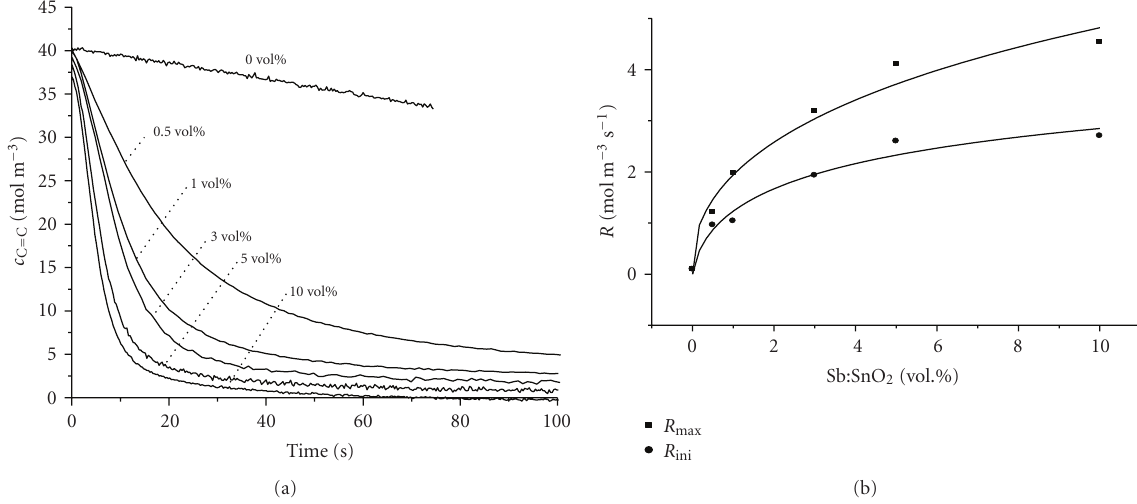
Figure 3: Dependency of the photocatalysed C = C bond conversion on Sb:SnO 2 concentration measured at 1637 cm − 1 (13% Sb; MPS / Sb:SnO 2 = 0 . 08 g/g). (a) The change in the (meth)acrylate C = C bond concentration during irradiation. (b) R max1637 and R ini1637 determined from the slopes in Figure 3(a) (points; (1)).] The solid lines represent the polymerization rate calculated with (5) using for K max1637 :2 . 20 × 10 − 4 m 3 / 2 s − 1 / 2 J − 1 / 2 and K ini1637 = 1 . 44 × 10 − 4 m 3 / 2 s − 1 / 2 J − 1 / 2